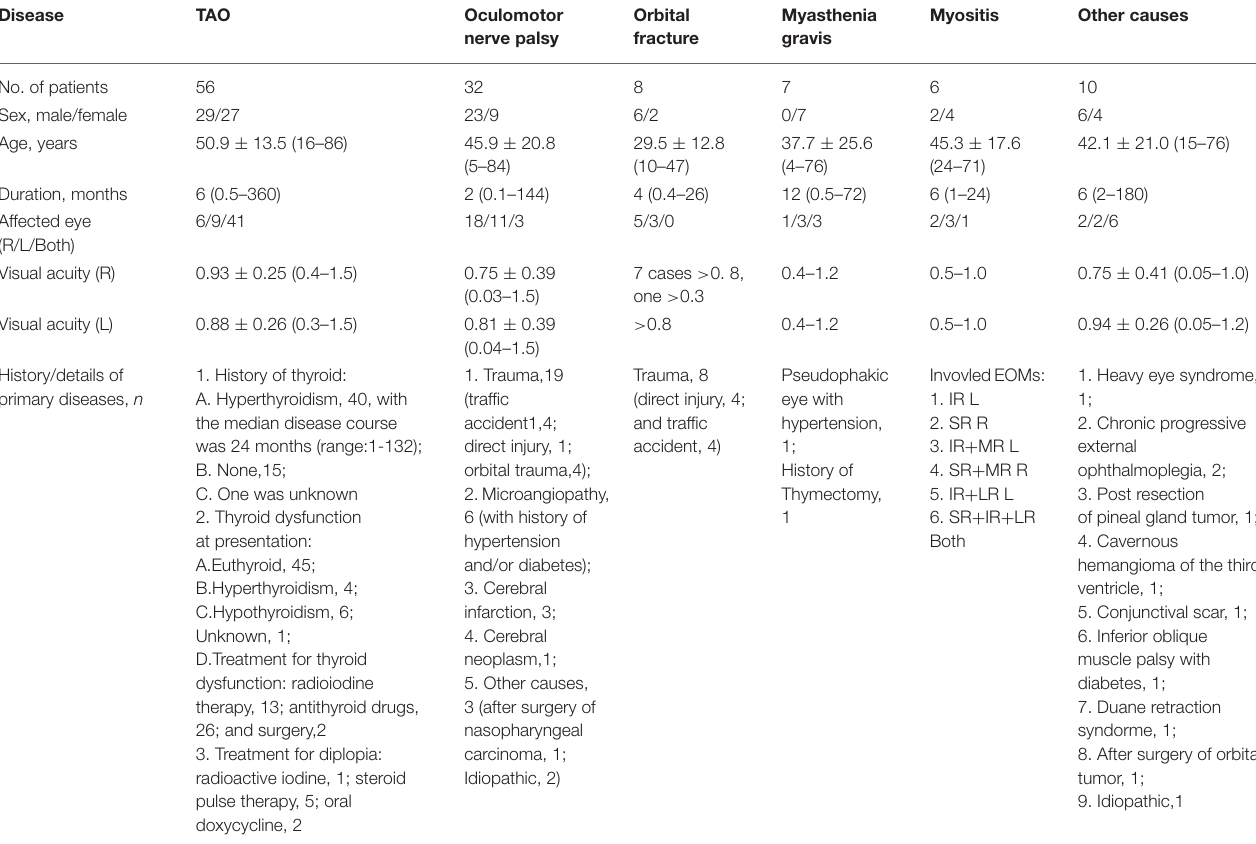
TABLE 4 | Characteristics of patients with paralytic strabismus with multiple EOMs involved. Disease